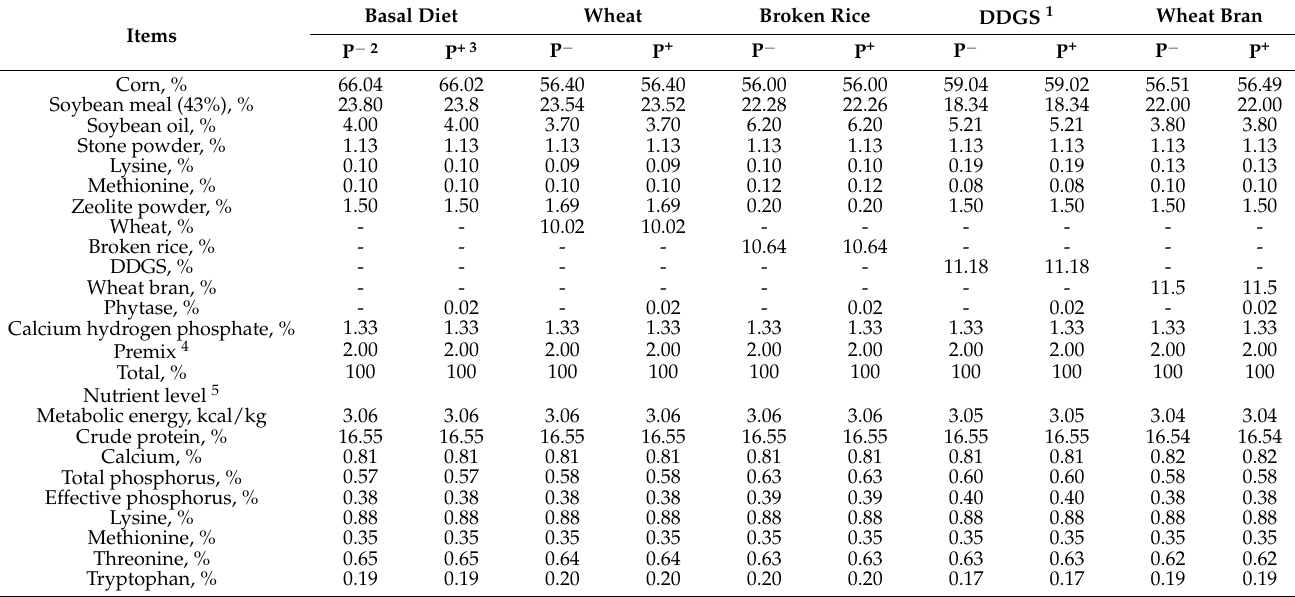
Table 3. Ingredient composition and nutritive value of the experimental